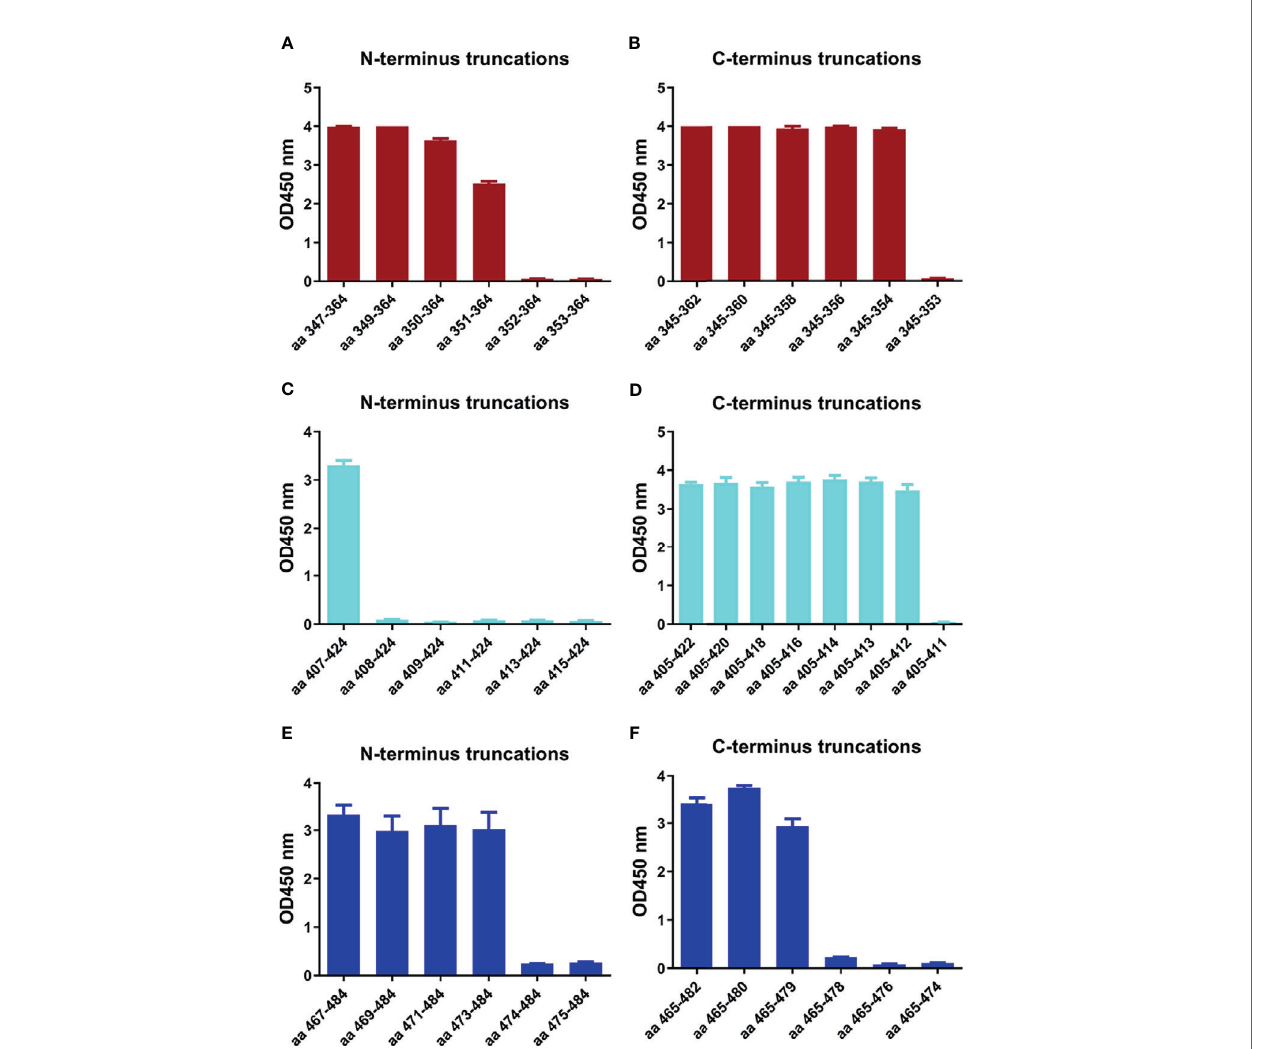
FIGURE 5 | Minimal motifs recognized by the mAbs against the identi fi ed linear B-cell peptides. (A, B) N-terminal and C-terminal truncations of peptide R345. (C, D) N-terminal and C-terminal truncations of peptide R405. (E, F) N-terminal and C-terminal truncations of peptide